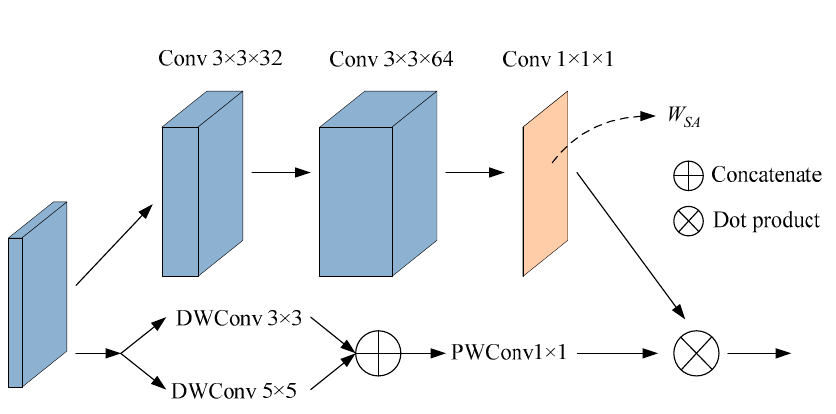
Figure 3. Spatial A tt ention Convolution Block (SACB). Figure 3. Spatial Attention Convolution Block